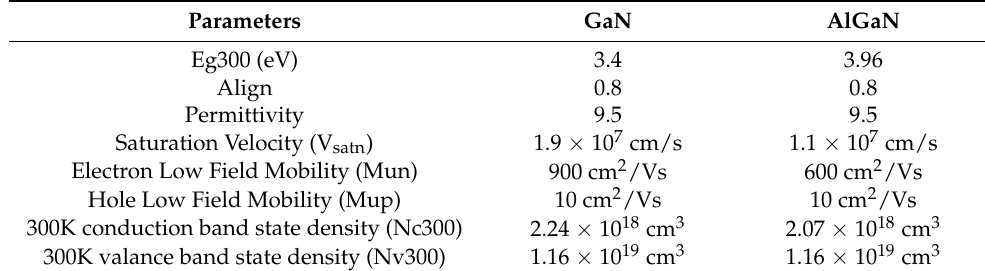
Figure 2. Electric field simulation of different types of AlGaN/GaN HEMT field plates. ( a ) No FP. ( b ) G-FP. ( c ) S-FP. ( d ) SG-FP. Table 1. Parameters for simulation